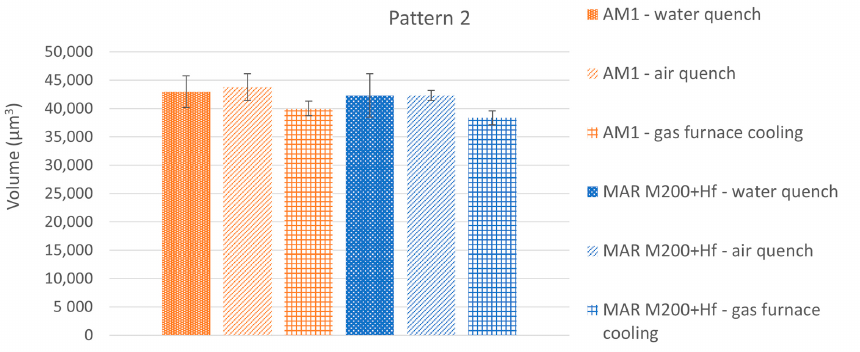
Figure 13. Thermally affected volumes of textured pattern 2 on AM1 and MAR M200 + Hf as a function of cooling kinetics.